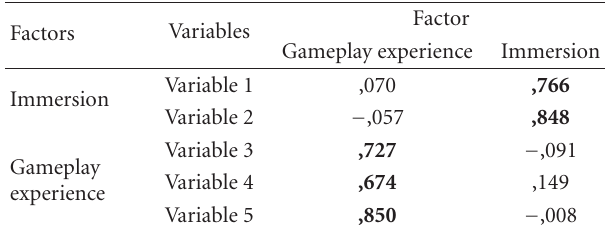
Table 5: Regression results.